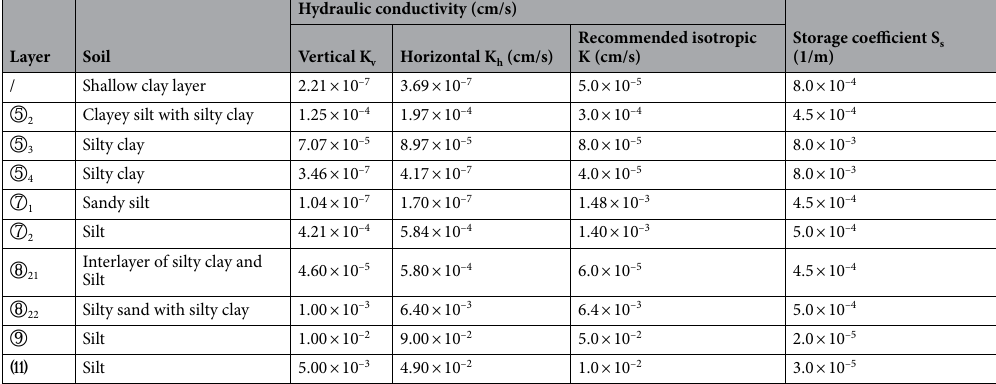
Table 1. Hydraulic parameter of the soil layers.